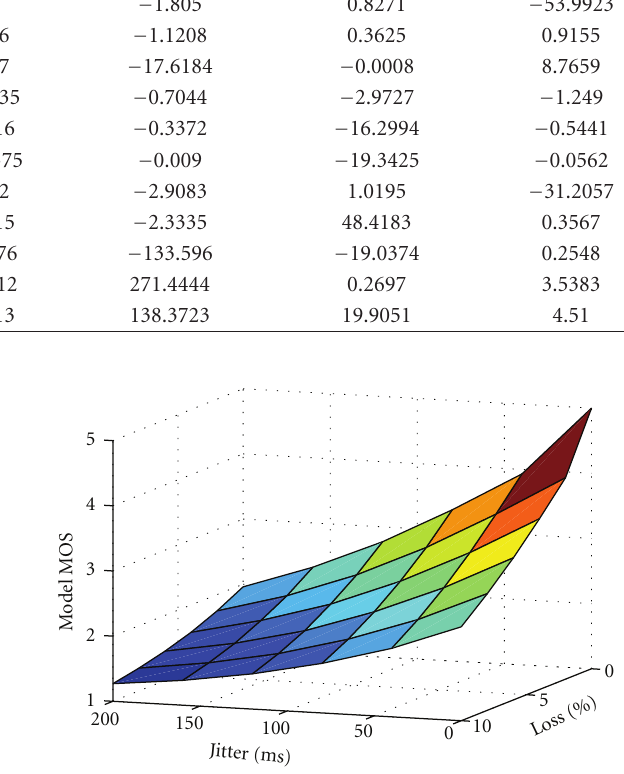
Figure 11: TFIFO QCIF model characteristics at 512Kbps bit